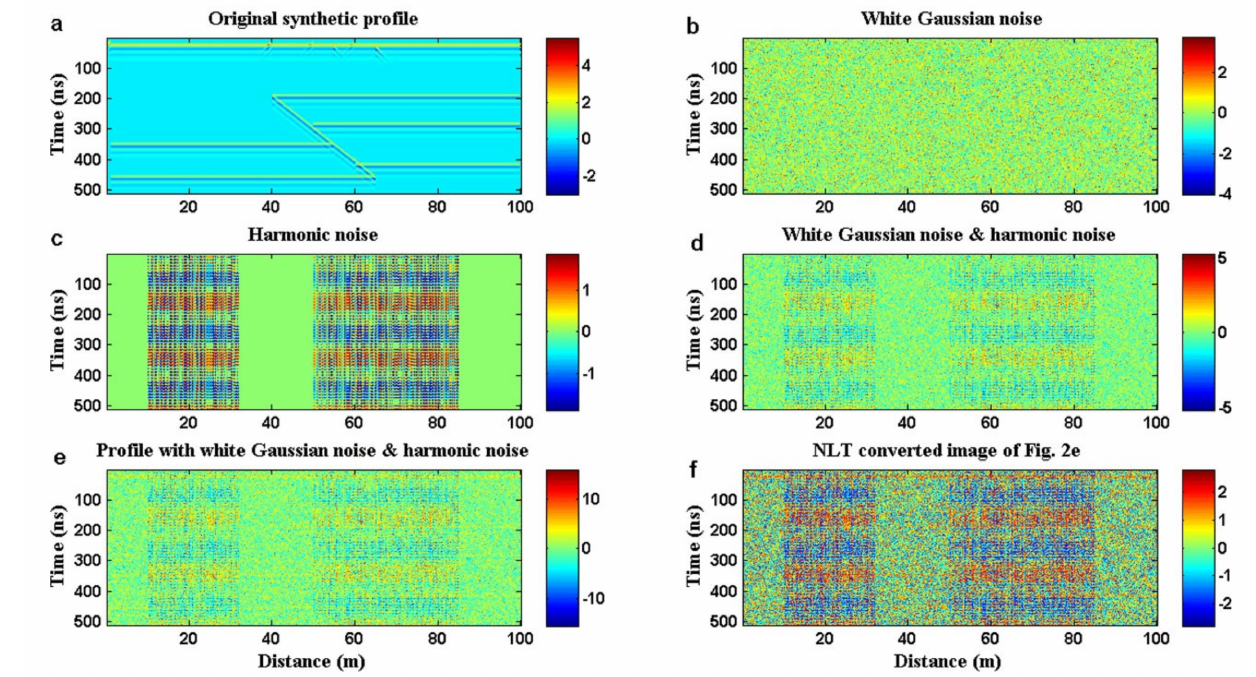
Figure 2. Synthetic hypothetical model profile, interfering noises, and noise-corrupted profiles. ( a ) GPR reflection profile of the proposed model. ( b ) White Gaussian noise. ( c ) Harmonic noise. ( d ) Combination of the white Gaussian noise and harmonic noise. ( e ) GPR reflection profile corrupted by the white Gaussian noise and harmonic noise. ( f ) NLT conversion of the noise-corrupted reflection profile. The model signal is invisible after noises are